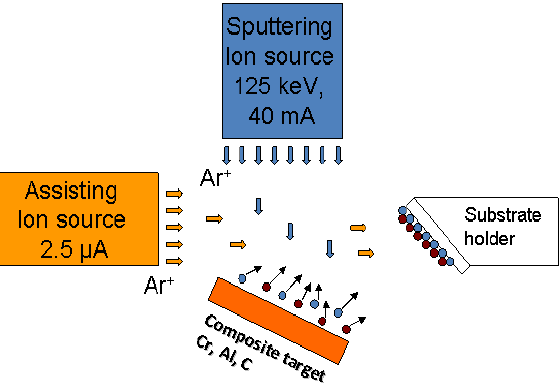
Figure 1. Schematics of the ion-assisted deposition process. Top-mounted ion source sputters the target while laterally mounted assisting ion source furnishes additional energy that help atoms to better bond on the substrate.